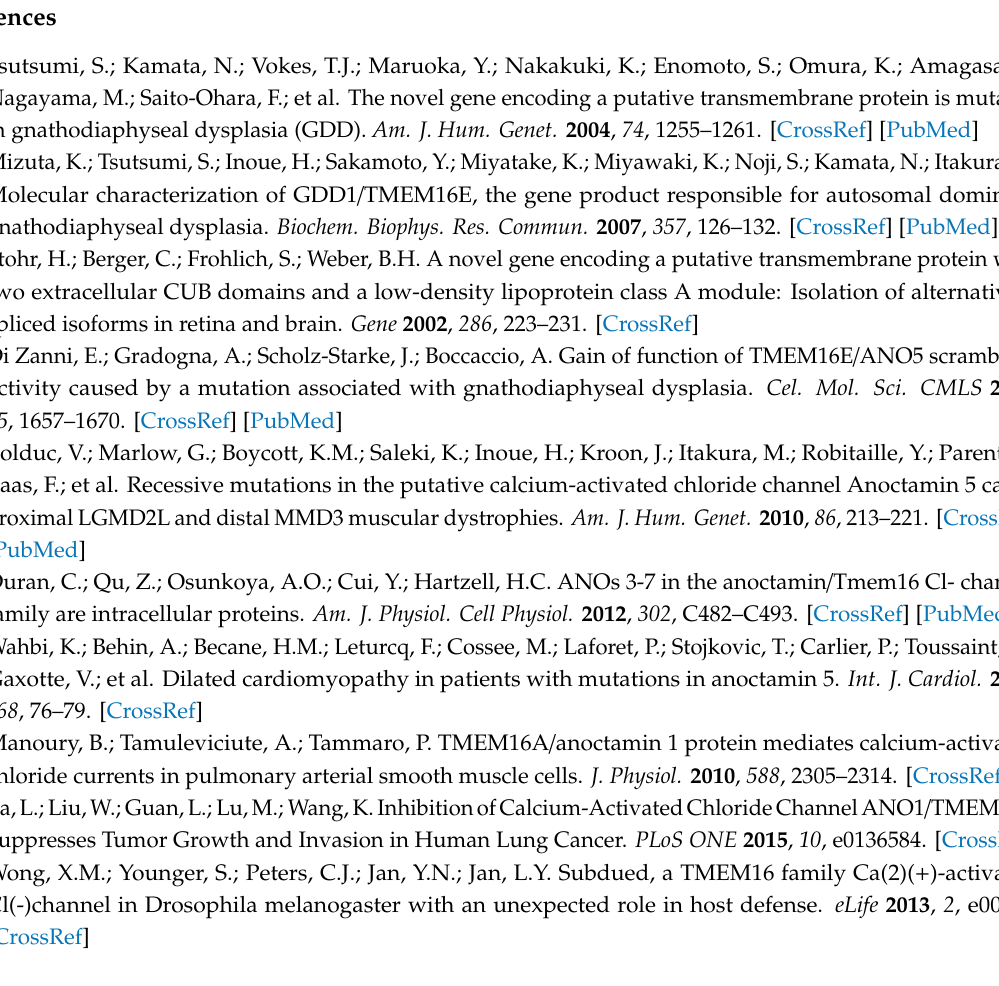
Figure S1: The generation of F1 carrying ANO5 mutant rabbits; Figure S2: The histological of WT and ANO5 − / − at the age of 6